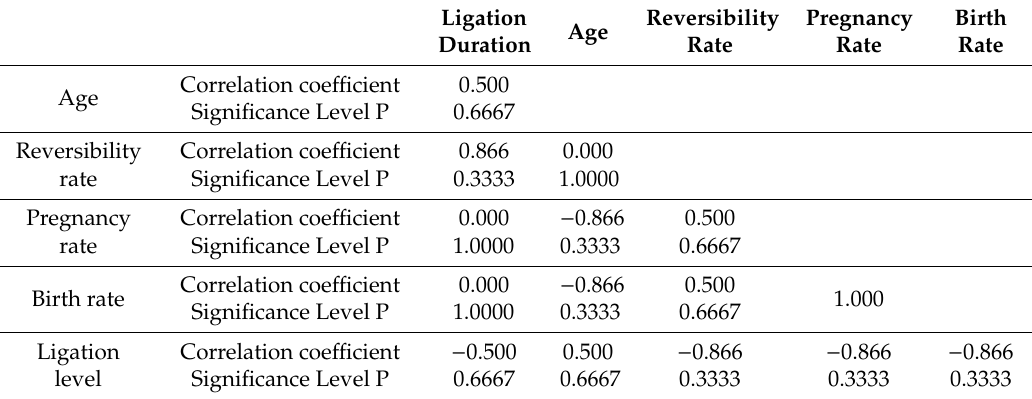
Table 5. Correlations between age group and reversibility rate, pregnancy rate, birth rate and ligation level for the patients aged 40 +